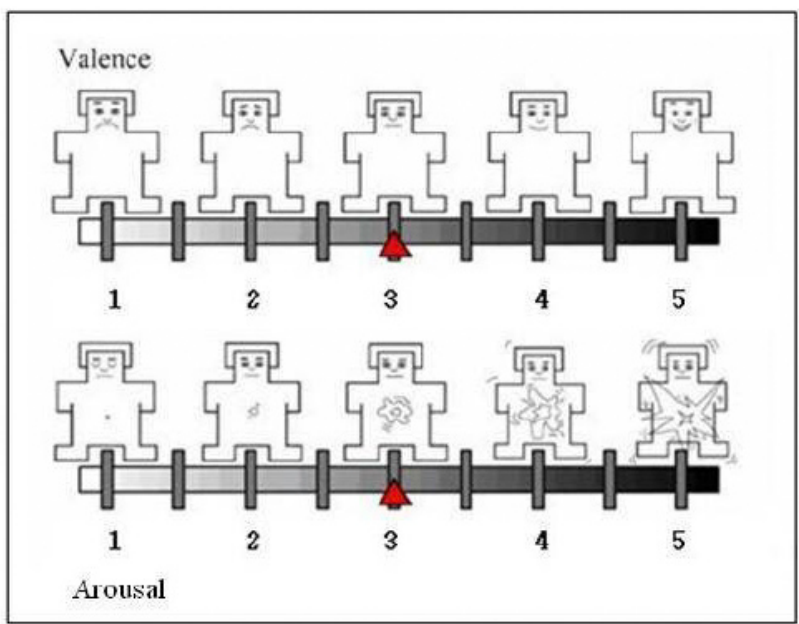
Figure 1. An example of the Self-Assessment Manikin for the measure of emotions’ characteristics. In this case, the participant is requested to rate the emotional valence and arousal of a stimulus on a 5-point scale. This figure has been reproduced with permission from Li et al. , 2011.